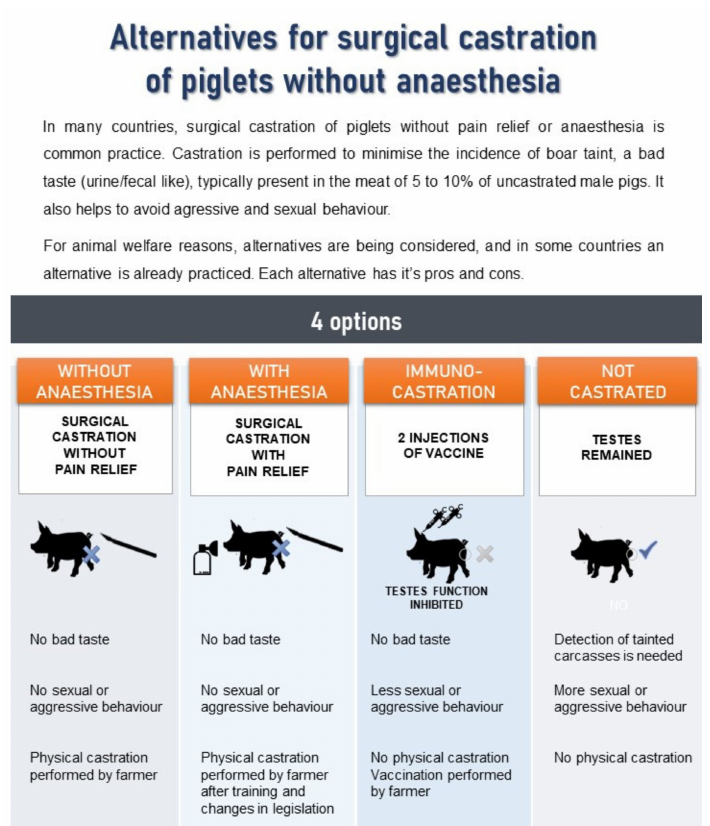
Figure 2. Infographic with information was provided before questioning the acceptance and attitude towards the di ff erent